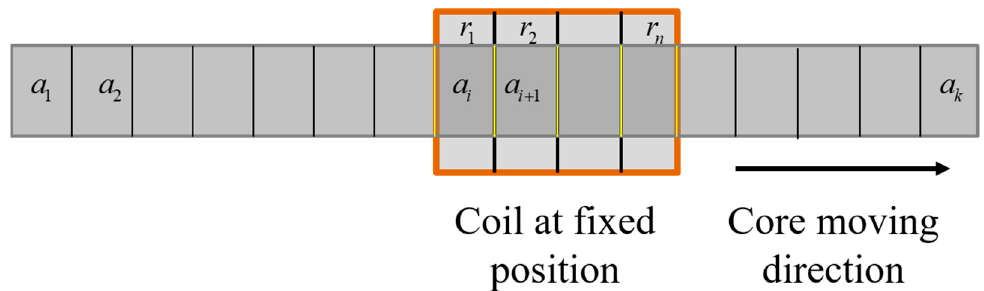
Figure 2. Illustration of the NMR measurements. The sample is moving to the right by one grid each time, and the coil is at a fixed position. The relationship between the measured NMR signal and the fluid content is given by Equation (5).